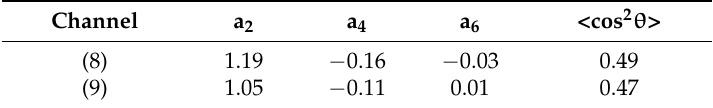
Table 3. Coefficients of Legendre expansion and expectation values of the squared-cosine of the two Coulomb explosion pathways for BCP 2+.